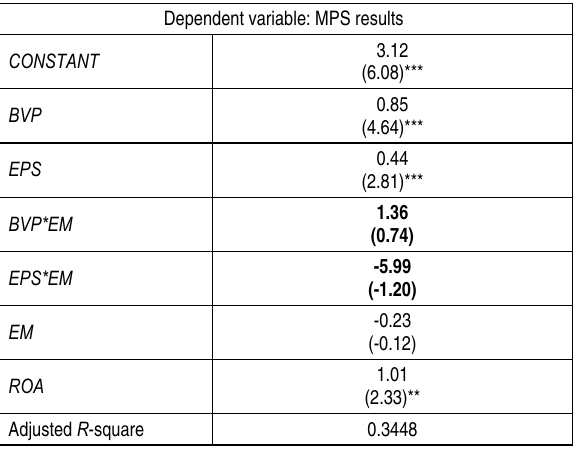
Table 9. Value relevance of accounting